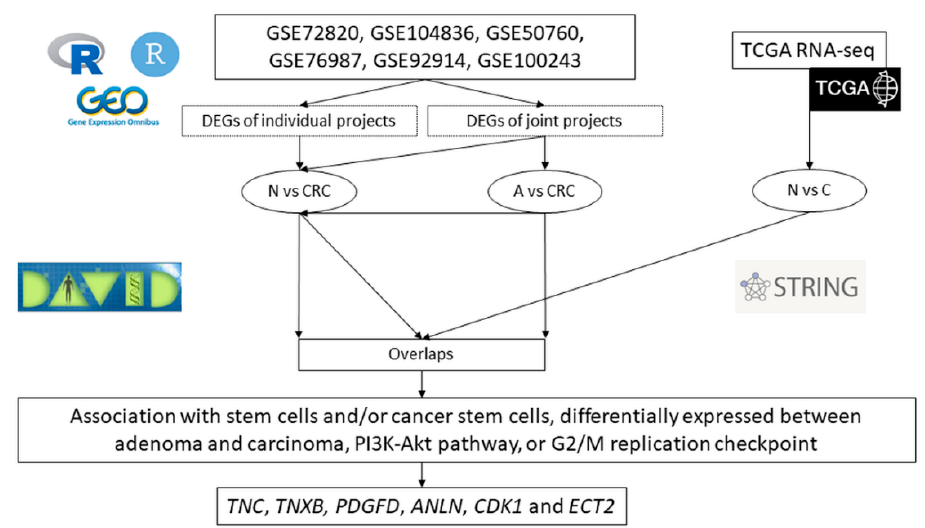
Figure 6. Workflow of identification of differentially expressed genes in the bioinformatics analysis. Legend: N, normal colon tissue; A, adenomas; CRC, colorectal cancer; DEGs, differentially expressed genes; TCGA, the cancer genome atlas; R, R programming language; R studio, R studio programme; DAVID, The Database for Annotation, Visualization and Integrated Discovery; STRING; STRING database for protein–protein interaction